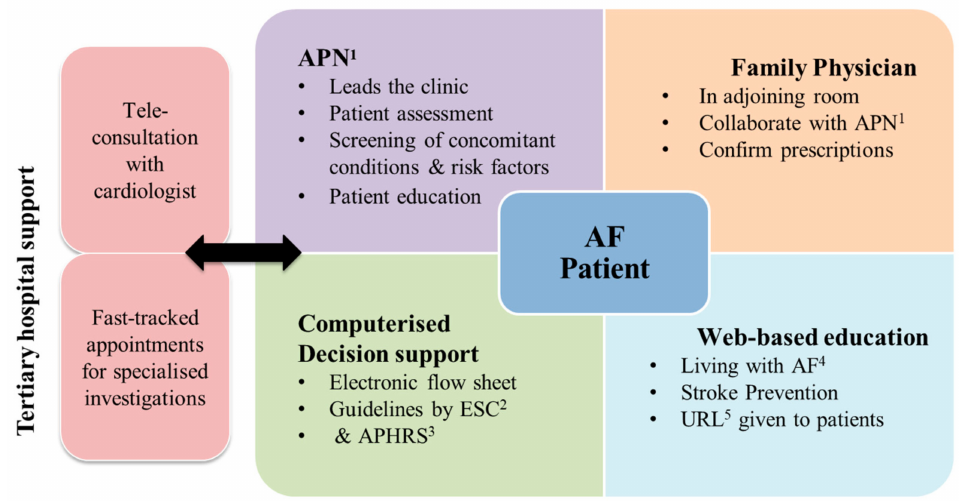
Figure 2. Outline of NICE-AF clinic. 1 Advanced practice nurse; 2 European Society of Cardiology; 3 Asia Pacific Heart Rhythm Society; 4 Atrial fibrillation; 5 uniform resource